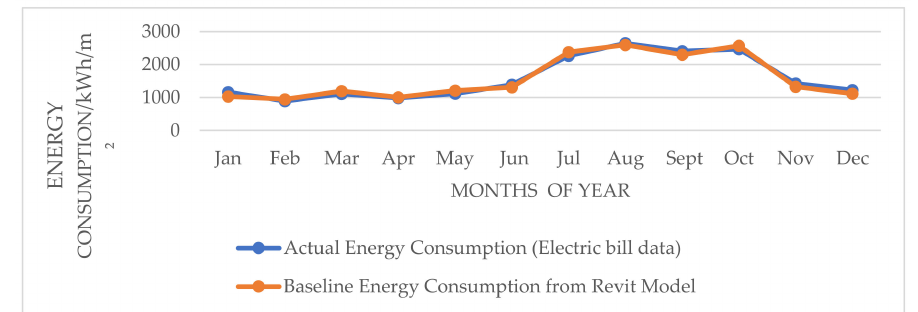
Figure 8. Comparison between actual and baseline energy usage.